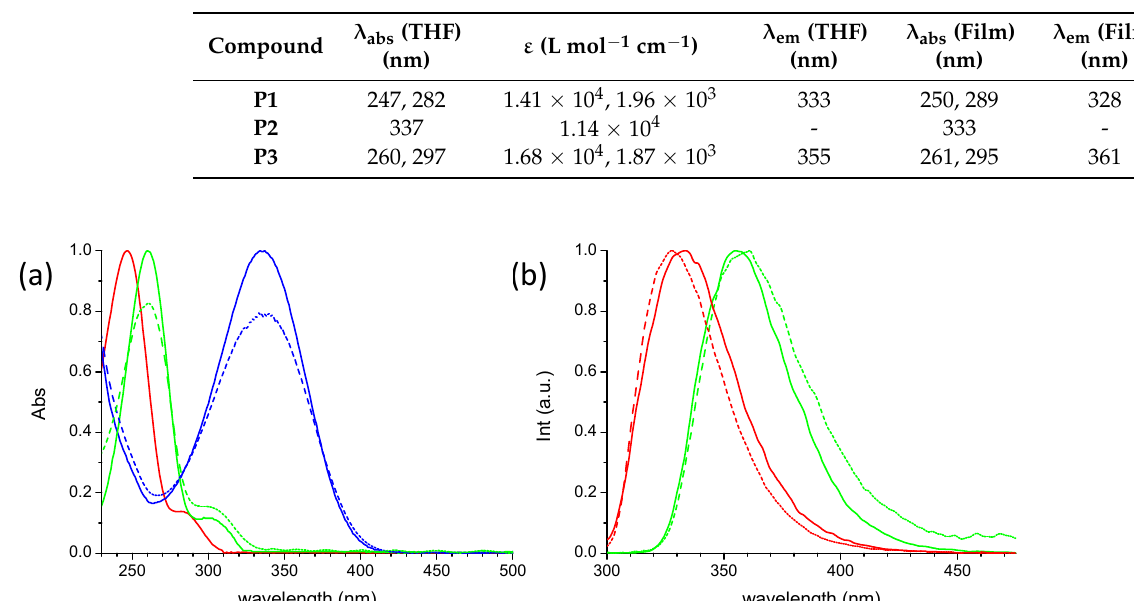
Table 3. UV-Vis absorption and fluorescence data.